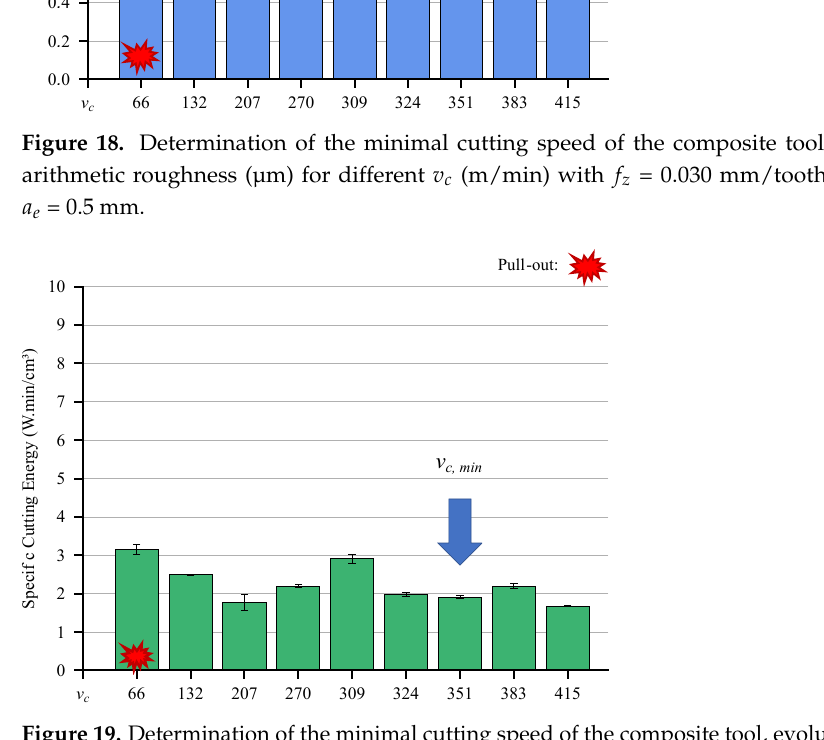
Figure 19. Determination of the minimal cutting speed of the composite tool, evolution of the specific cutting energy (W · min/cm 3 ) for different v c (m/min) with f z = 0.030 mm/tooth, a p = 3 mm, and a e = 0.5